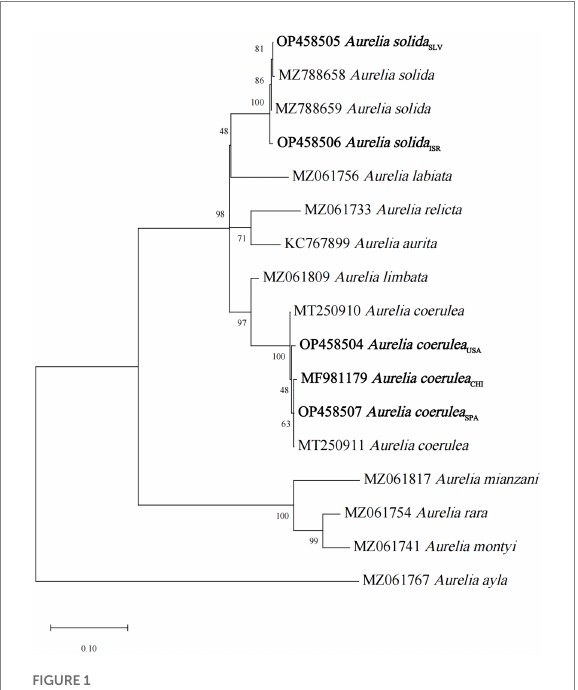
FIGURE 1 Maximum-likelihood tree for 16S rRNA gene sequences of the studied Aurelia scyphistomae